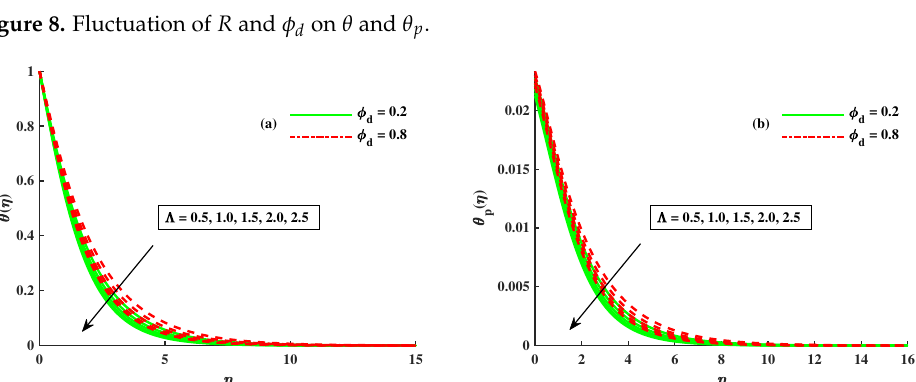
Figure 9. Fluctuation of Λ and φ d on θ and θ p . Figure 10a,b portray the skin friction factor in x and y direction for different inputs of rotating parameter, material parameter, and dust particle concentration